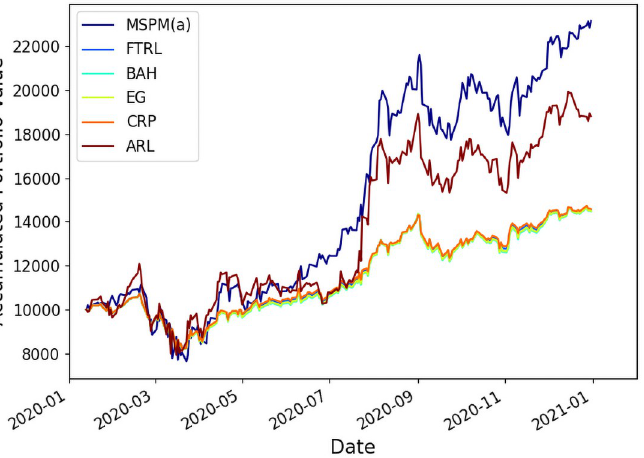
Fig 7. MSPM(a) outperforms all baselines on Portfolio(a) in terms of the accumulated portfolio value in back-